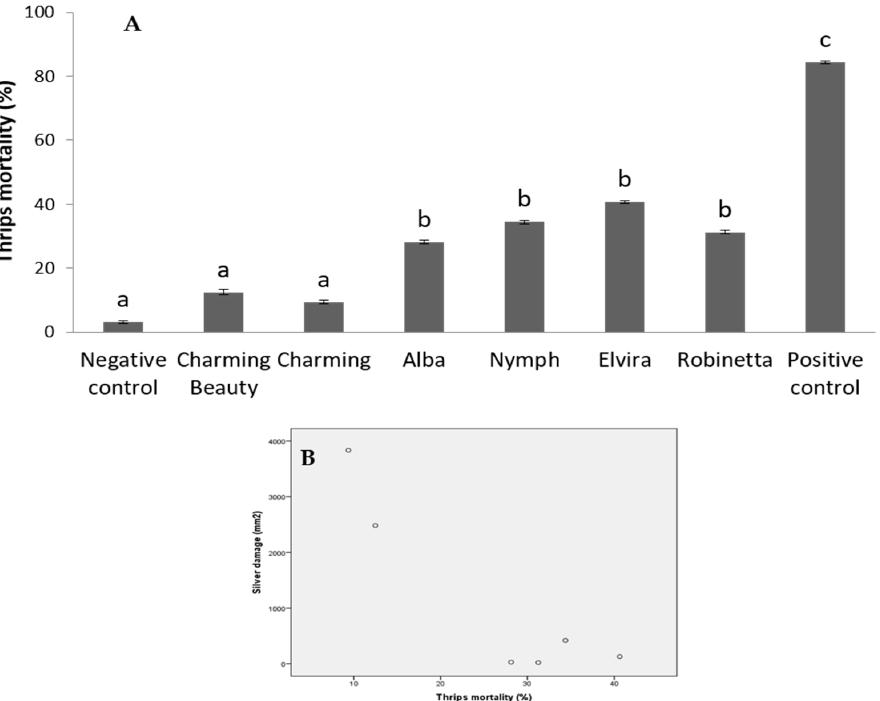
Figure 6. ( A ) Mortality of thrips feeding on artificial diets (150 µL of 2% agarose) with 50 µL of leaf extracts of six Gladiolus varieties measured in an in vitro bioassay. For each extract, 32 thrips were tested 5% methanol solution was used as a negative control and the insecticide abamectin (50 µg/mL) as a positive control. Means and standard errors are presented. Different letters indicate significant differences between varieties at p ≤ 0.05. ( B ) Correlation between thrips silver damage, measured in a whole-plant non-choice bioassay, and thrips mortality measured in the in vitro bioassay of six Gladiolus varieties ( r = − 0.788, N = 6, p = 0.031).